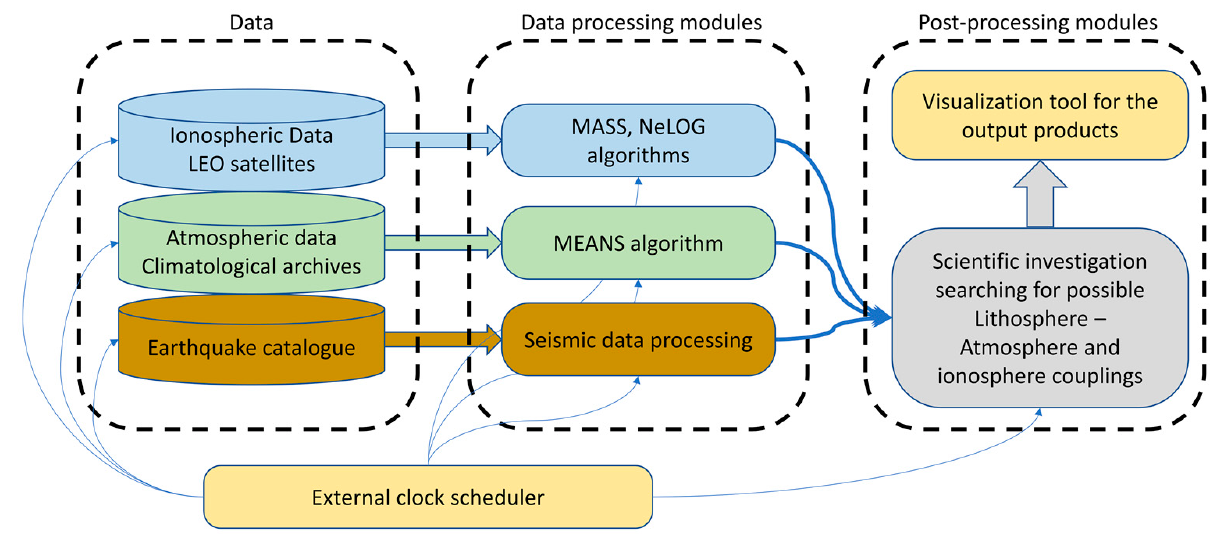
Figure 12. Concept of a real-time geophysical multiparametric platform to investigate and system- atically search for lithosphere, atmosphere, and ionosphere coupling phenomena.